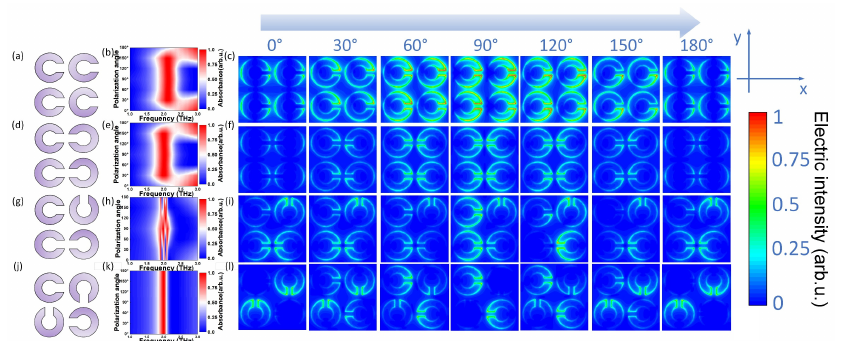
Figure 1. Simulation results of different element biosensor designs under different polarization angles. ( a – c ) Structure diagram of the same opening direction, corresponding frequency shift and electric field distribution. ( d – f ) Structure diagram of SPR biosensor with axisymmetric orientation opening, corresponding frequency shift and electric field distribution ( g – i ) Structure diagram of SPR biosensor with random direction of opening, corresponding frequency shift and electric field distribution. ( j – l ) Structure diagram of SPR biosensor with open center symmetry, corresponding frequency shift and electric field distribution.